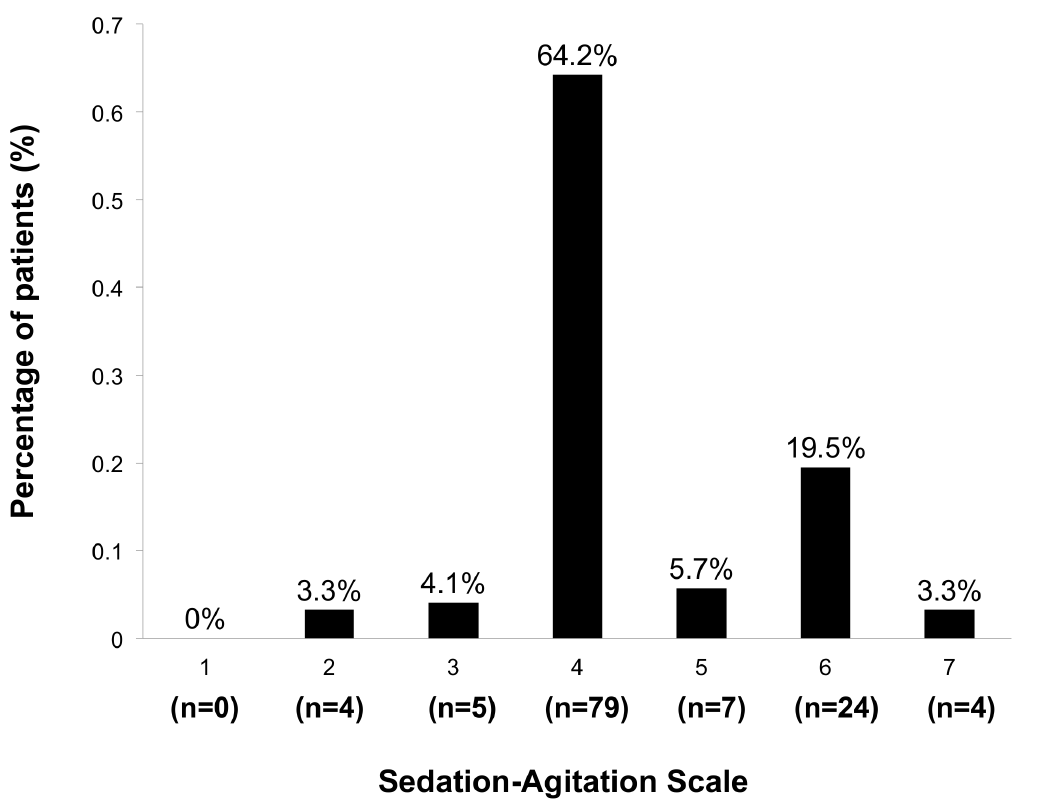
Fig. 2. Distribution of the maximal sedation-agitation scale (SAS) in the study